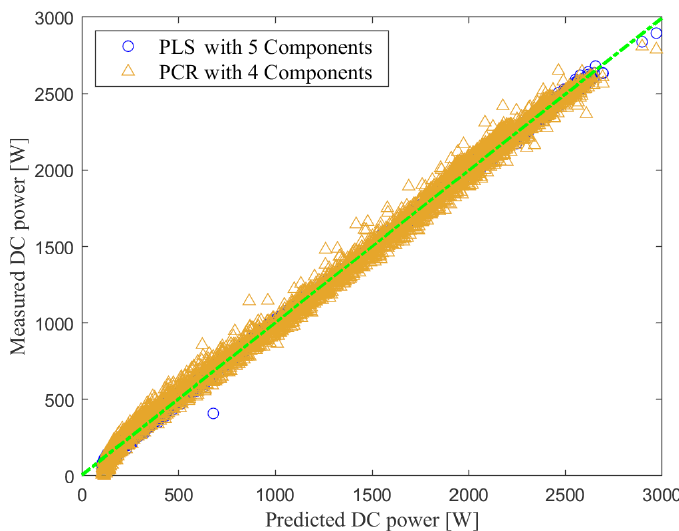
Figure 10. Scatter plot of the measured and predicted DC power using PLS and PCR models.